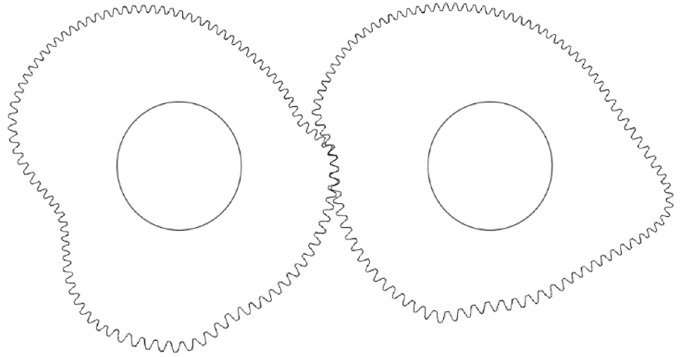
Figure 11. Final driven gear generated according to the designed driving gear.